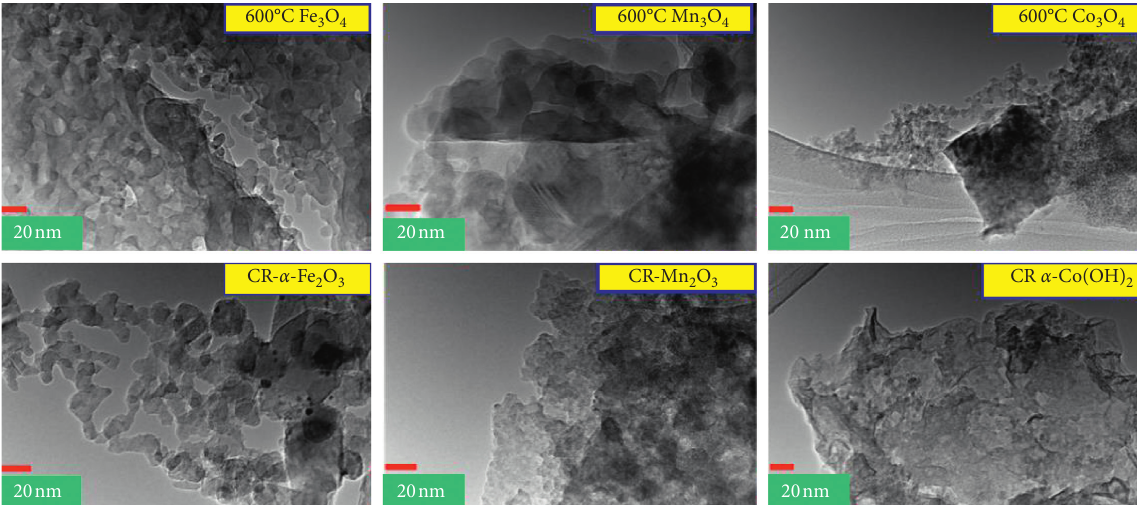
Figure 7: HRTEM images of Fe 3 O 4 , Mn 3 O 4 , and Co 3 O 4 metal oxide NPs obtained from the calcination of [EMIM-Cl][FeCl 2 ], [EMIM-Cl] [MnCl 2 ], and [EMIM-Cl][CoCl 2 ], respectively, at 600 ° C, whereas, α -Fe 2 O 3 , Mn 2 O 3 , and α -Co(OH) 2 were obtained from chemical treatment with NaBH 4 .